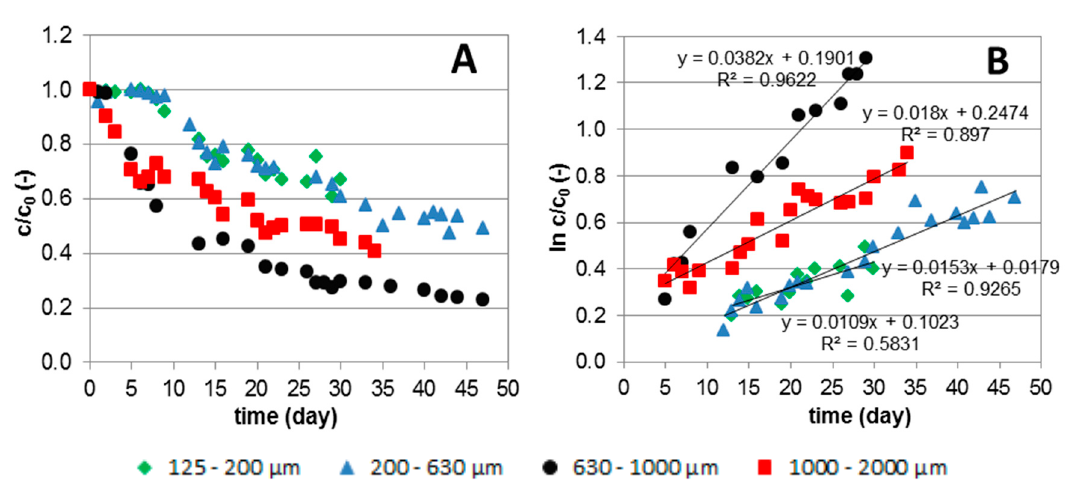
Figure 3. Degradation of DOC for the different fractions presented as c/c 0 versus time ( A ) and exponential degradation phase of DOC presented as logarithm of c/c 0 versus time ( B ).